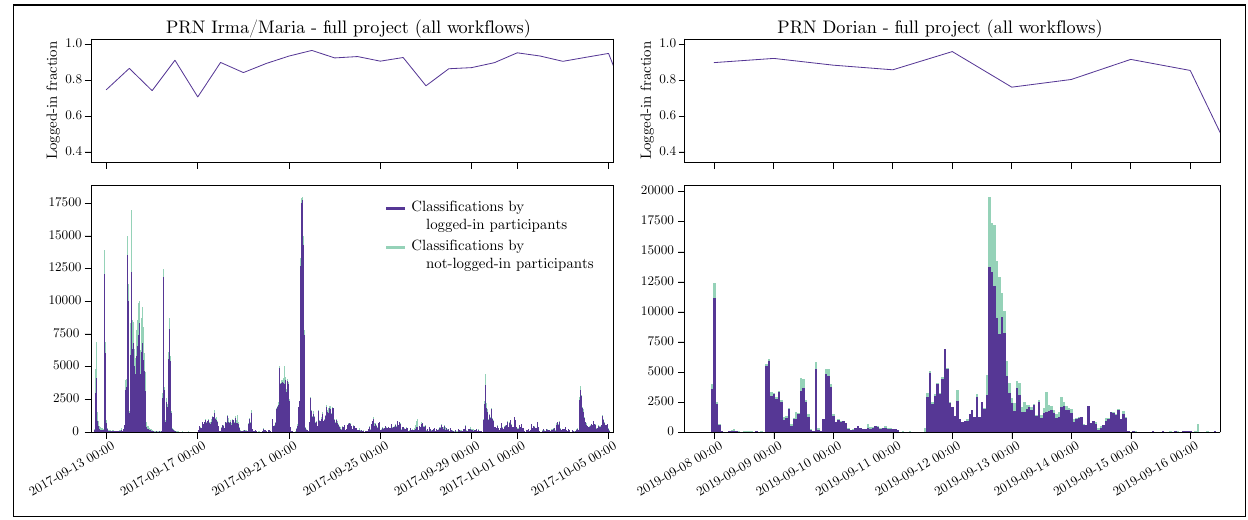
Figure 3 Classifications over time for Planetary Response Network Caribbean deployments (2017, left ; 2019, right ). Classifications from logged-in participants are shown in purple; classifications from not-logged-in participants are added in light green, such that the combined hourly histogram shows overall classification totals. Upper panels show the daily fraction of classifications from logged-in